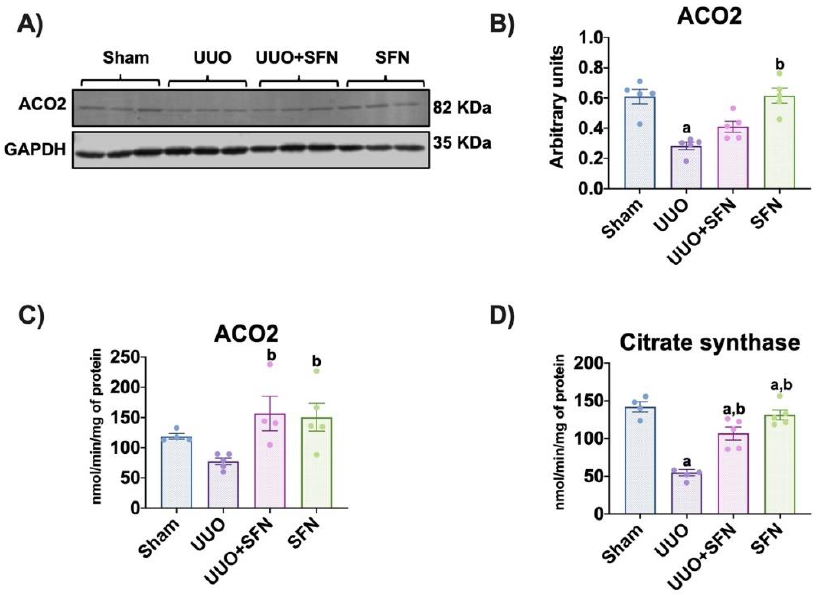
Figure 6. Sulforaphane (SFN) effect in the TCA cycle. ( A ) Representative immunoblotting and ( B ) densitometric analysis of the levels of aconitase 2 (ACO2). Data are mean ± SEM, n = 5 per group. Data were analyzed using a one-way ANOVA and statistical differences were determined by multiple comparisons using Tukey’s test. Glyceraldehyde phosphate dehydrogenase (GAPDH) was used as a loading control. ( C ) ACO2 and ( D ) citrate synthase activities from the kidney cortex of the different experimental groups were evaluated in isolated mitochondria and total homogenates, respectively. Data are mean ± SEM, n = 5 per group (except for sham for ACO2 and citrate synthase, n = 4, and UUO + SFN for ACO2, n = 4). Data were analyzed using a one-way ANOVA, and statistical differences were determined with multiple comparisons using Tukey’s test a p < 0.05 vs. Sham, b p < 0.05 vs. UUO. Sham: simulated surgery without ligation of the ureter; UUO: unilateral ureteral ob-